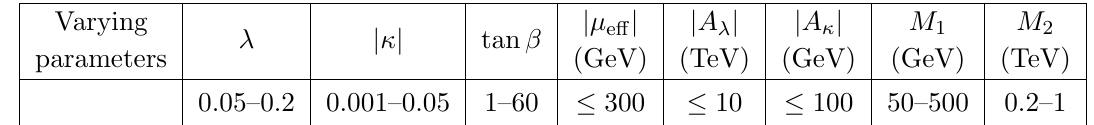
Table 1 . Ranges of various model parameters adopted for scanning the Z 3 -symmetric NMSSM parameter space. All parameters are de(cid:12)ned at the scale Q 2 = (2 m 2 tan (cid:12) which is de(cid:12)ned at m Z (see text for